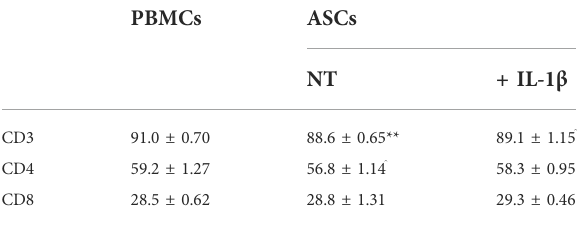
TABLE 2 Modulation of Tcellssurvivaland phenotype by ASCsprimed or not with IL-1 β